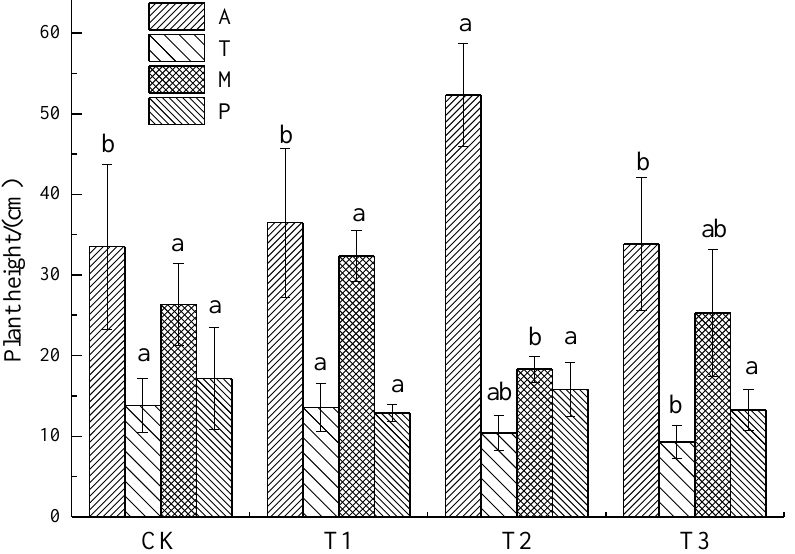
Figure 1. Plant heights of native plants species under different treatments in the Pb-polluted soil. Data shown are means ± standard error ( n = 5), and different letters (a, b) represent significant differences at p < 0.05.